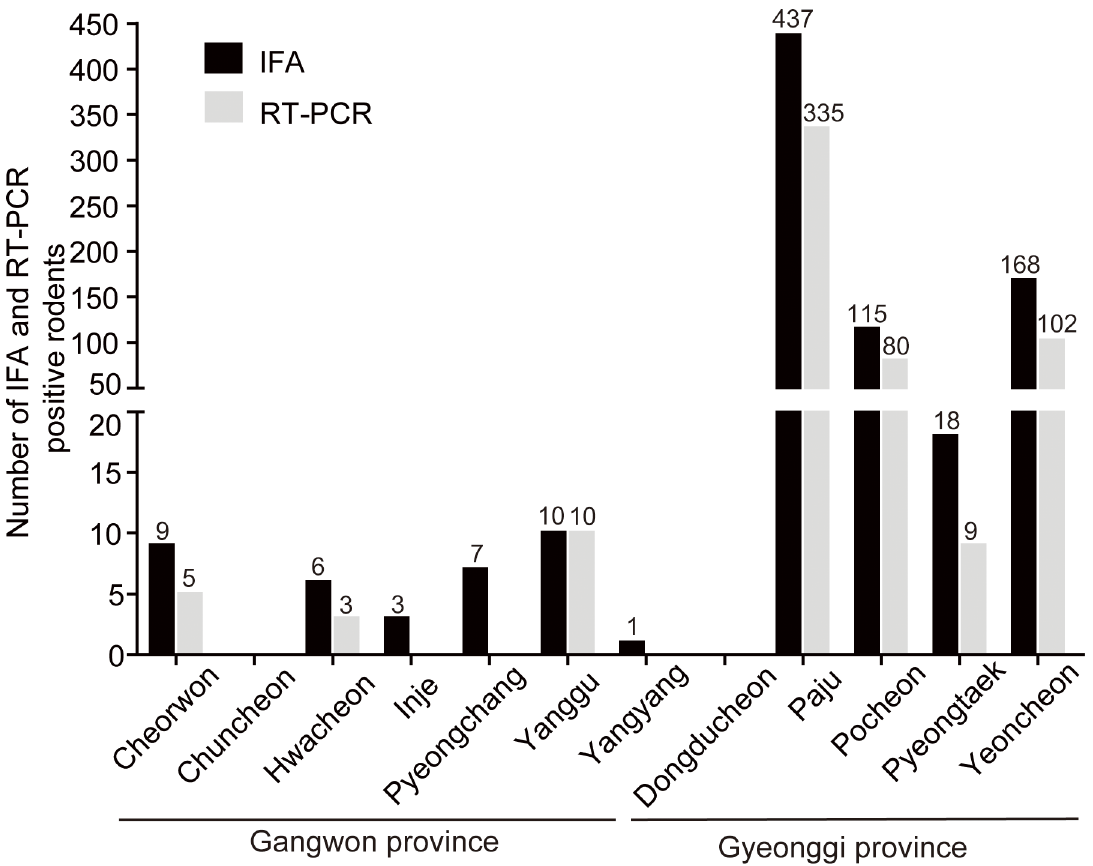
Fig 2. The serological and molecular prevalence of HTNV from A . agrarius in Gangwon and Gyeonggi provinces. A total of 5,929 A . agrarius were captured in the Gangwon and Gyeonggi provinces from 2003 – 2014. A total of 774 A . agrarius were seropositive for anti-HTNV IgG (shown by black bars). Grey bars represent 544/774 A . agrarius that were positive for the partial HTNV M segment. Arabic number above the bars indicates the number of IFA and RT-PCR positive rodents,